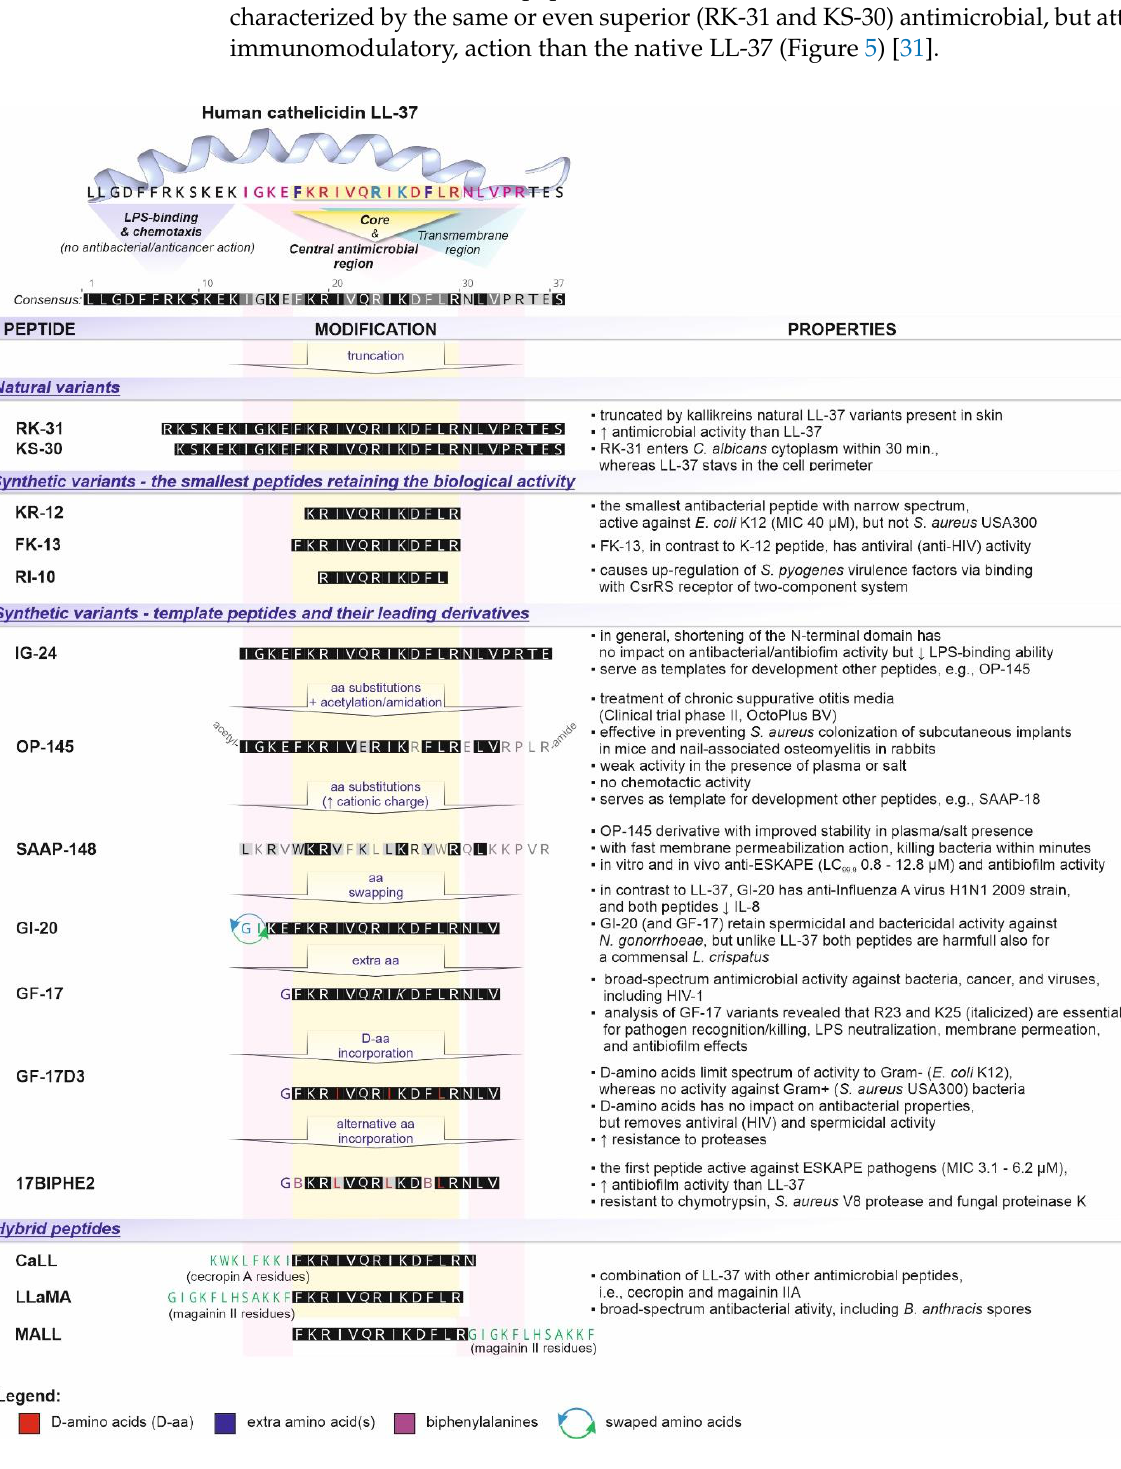
Figure 5. LL-37 and its selected natural and synthetic variants. Amino acids identical to the residues in native LL-37 are illustrated on a black background (with white letters); the others represent substitutions and/or modifications. The core antimicrobial region LL-37 residues essential for its interaction with cell membranes, i.e., phenylalanines F17/F27, and pathogen recognition/killing; LPS neutralization; membrane permeation; and antibiofilm effects, i.e., arginine — R23 and lysine — K25, are in bold and highlighted in violet and green, respectively.